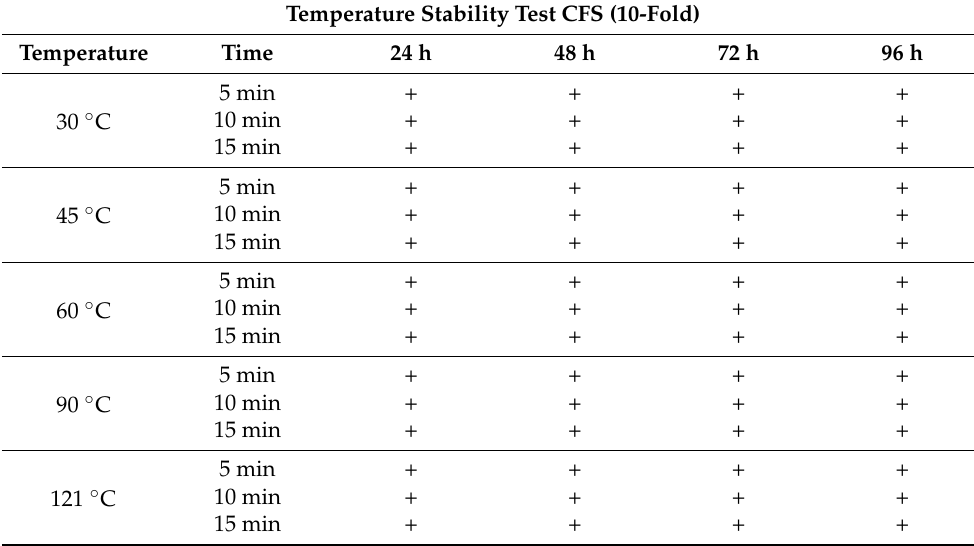
Table 3. Temperature stability test of the cell-free supernatant (CFS) of L. plantarum YML015.